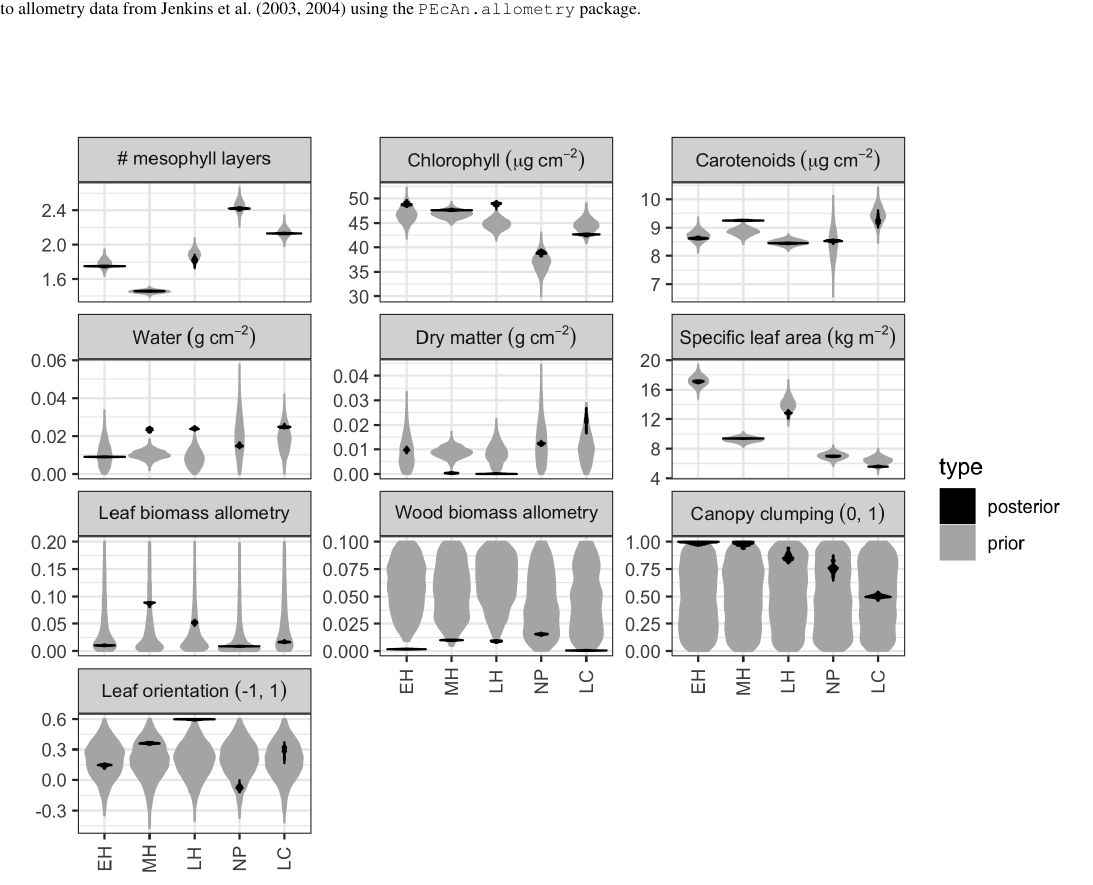
Figure 3. Marginal prior (pre-calibration; gray) and posterior (post-calibration; black) distributions of PFT-specific parameters related to leaf biochemistry and canopy structure. Distributions are shown as violin plots (rotated and mirrored kernel density plots). PFTs are abbreviated as follows: EH: early hardwood; MH: north mid-hardwood; LH: late hardwood; NP: northern pine; LC: late conifer. Leaf and wood biomass allometry panels are clipped at 0.2 to facilitate differentiation of posterior